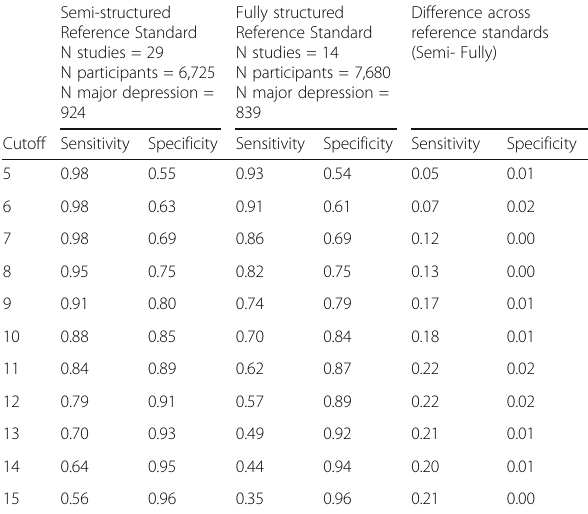
Table 1 (abstract P40). Diagnostic accuracy of the PHQ-9 by reference standard Semi-structured Reference